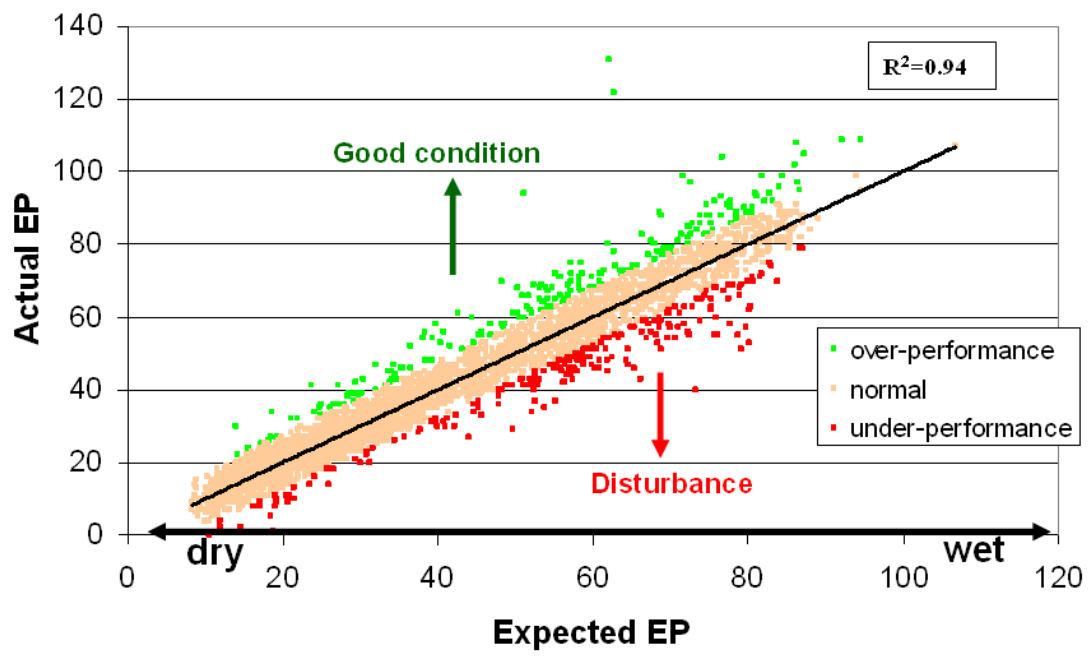
Figure 4 . Expected ecosystem performance compared with the actual ecosystem performance for 2005–2007. Pixels were randomly selected from big sagebrush areas in the UCRB. Green points represent overperformance and are greater than the 90% confidence limit above the regression line. Red points represent underperformance and are greater than the 90% confidence limit below the regression